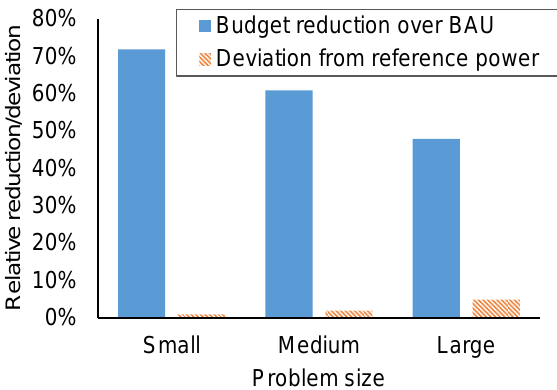
Figure 9. Average relative budget improvement over business-as-usual scenario and relative deviation from power reference computed by ev-MOGA for a relative quality of service over